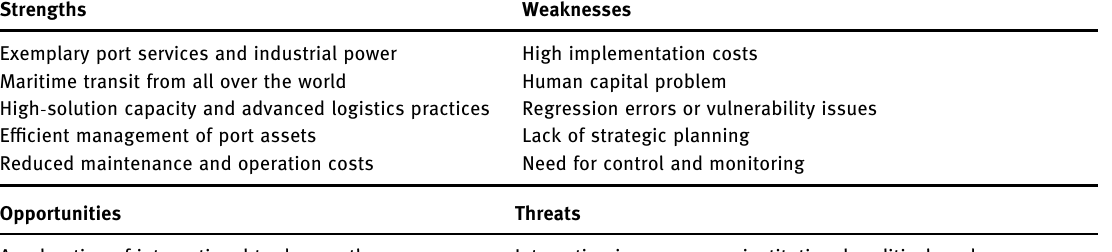
Table 4: SWOT analysis for ports Strengths